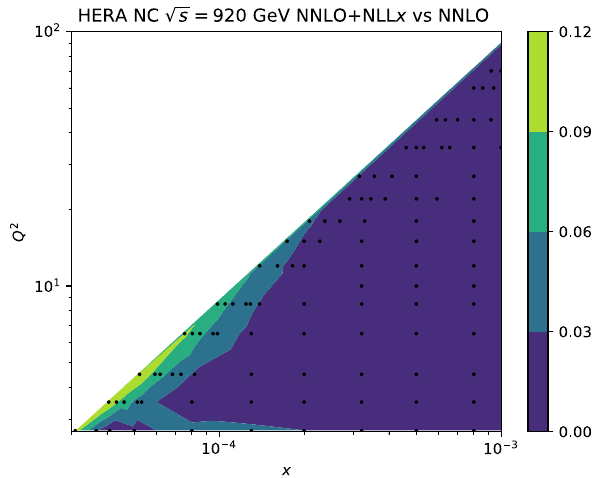
Fig. 26 Same as Fig. 25, now for the relative difference in the the- oretical predictions of the HERA reduced cross-sections between the NNLO and NNLO+NLL x fits, Eq. (5.6). Note the different color code and x and Q 2 ranges with respect to Fig. 25